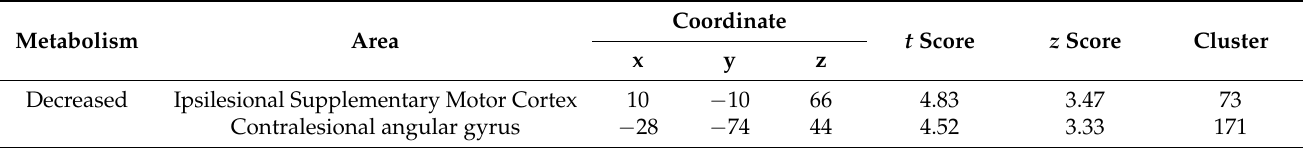
Table 4. Area of the brain that showed altered glucose metabolism in patients with central post-stroke